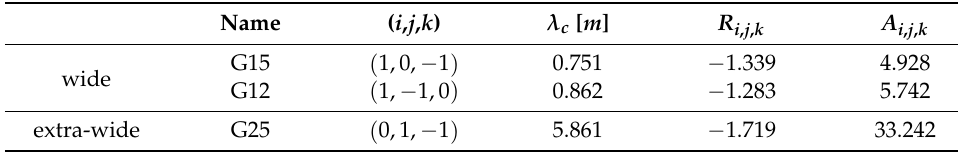
Table 2. Wide-lane combination of GPS.